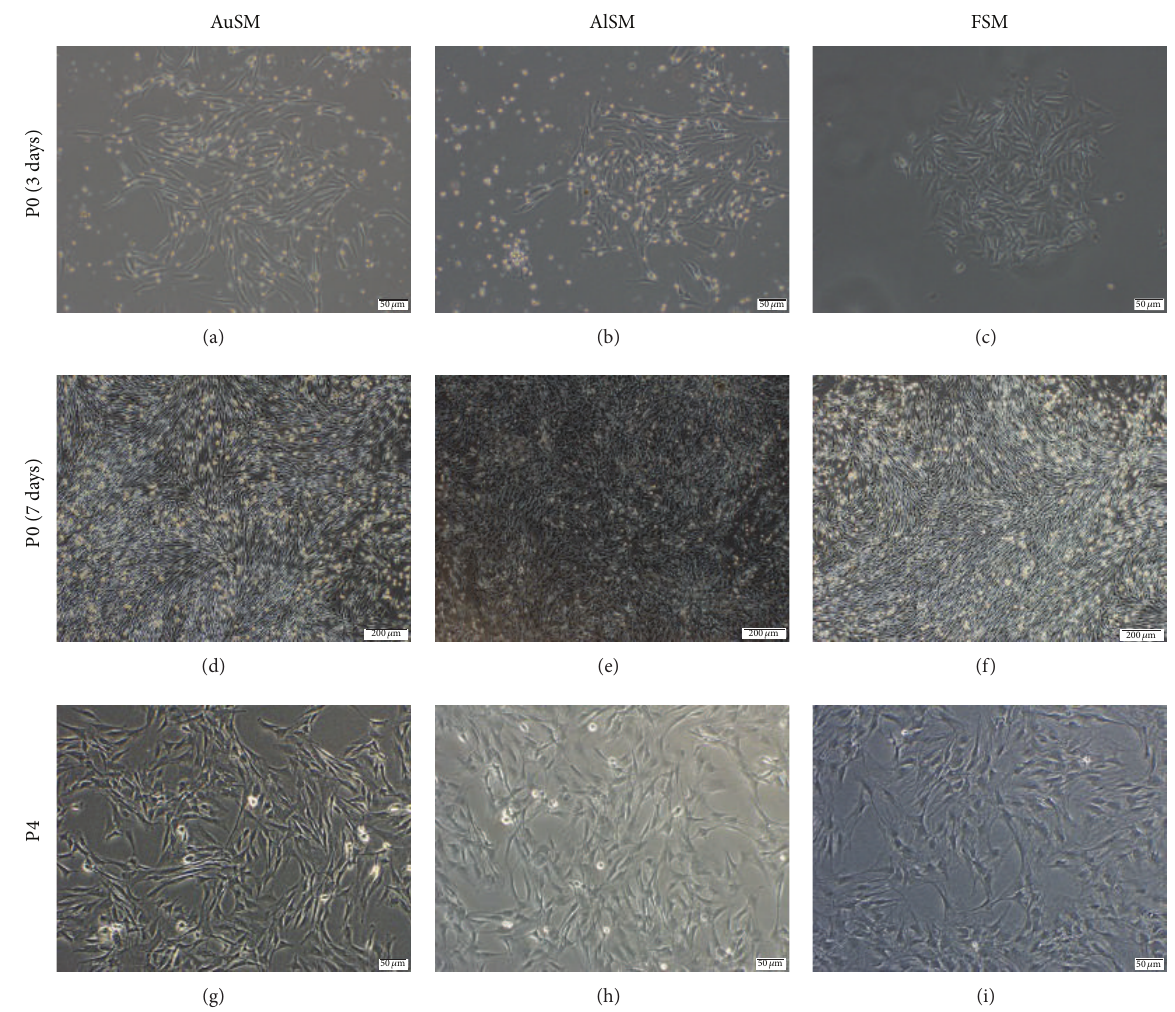
Figure 2: Morphologies of primary and secondary (P4) cultures of BMSCs cultured in (a, d, and g) AuSM, (b, e, and h) AlSM, and (c, f, and i) FSM. Scale bars in (a), (b), (c), (g), (h), and (i) = 50 𝜇 m, and scale bars in (d), (e), and (f) = 200 𝜇